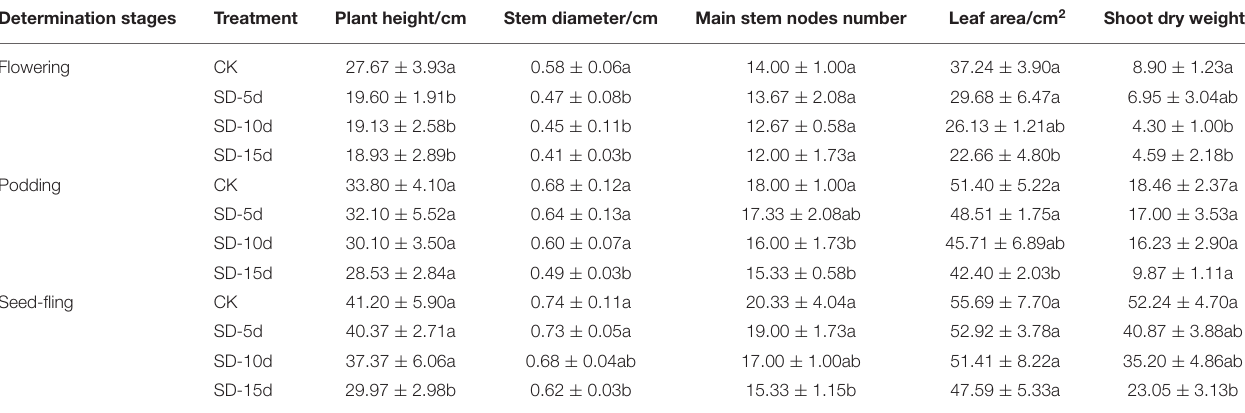
TABLE 3 | Growth of adzuki bean under short-day photoperiod inducement. Determination